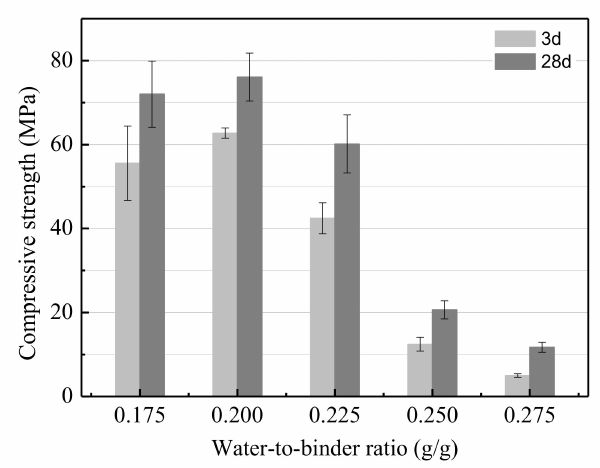
Figure 4. The e ff ect of the water-to-binder ratio on the UCS.